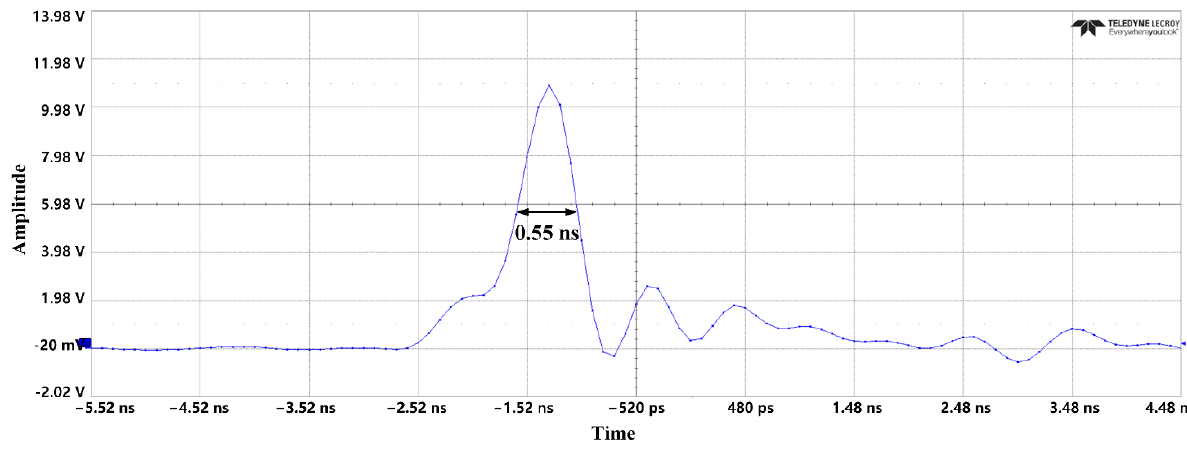
Figure 12. UWB attenuation waveform.